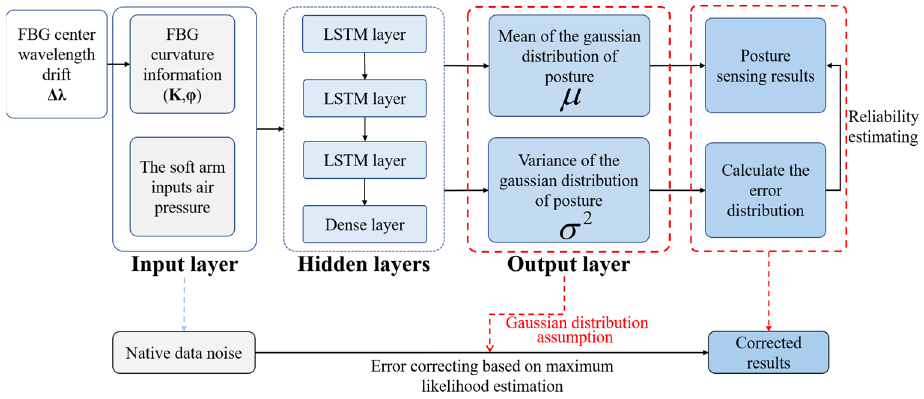
Figure 4. Posture sensing and error correcting using LSTM neural network (Appendix A).